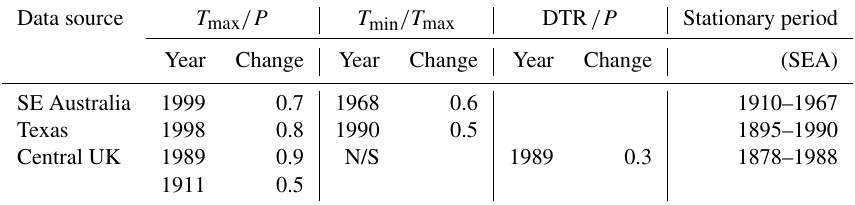
Table 2. Year of non-stationarity in regional temperature for south-eastern Australia, Texas and central England. Data source, year of first change greater than 1 standard deviation for T max against P and T min against T max , or DTR /P using the bivariate test. The stationary period is also